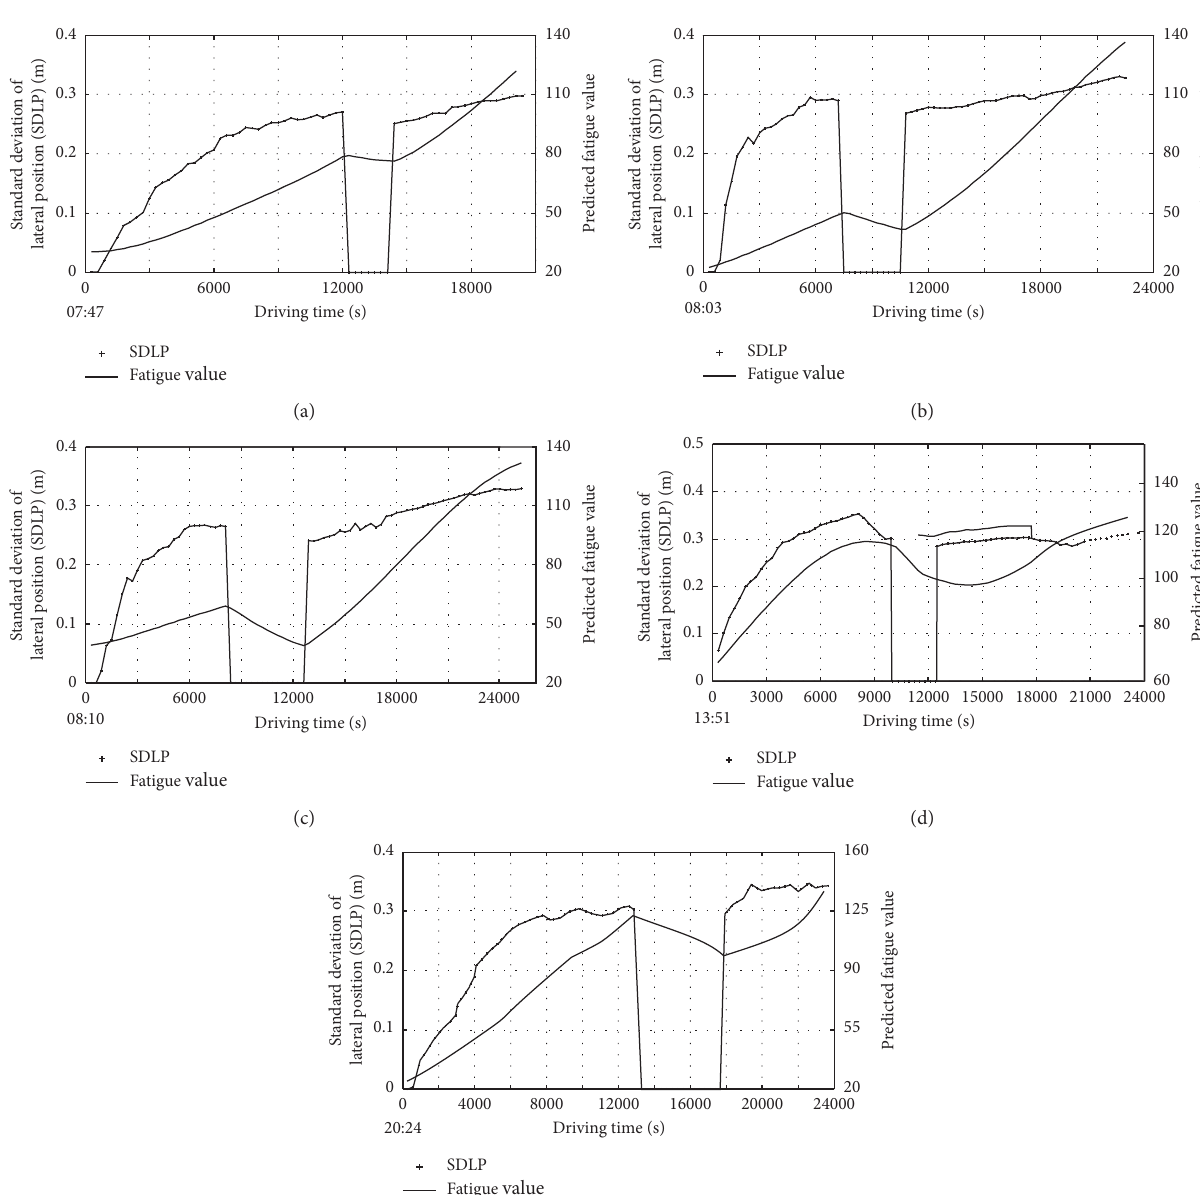
Figure 12: Comparison of the SDLP with the fatigue value of the three participants. (a) Subject with 7.4 hours of sleep. (b) Subject with 5.5 hours of sleep. (c) Subject with 3.8hours of sleep. (d) Subject with 7.7 hours of sleep. (e) Subject with 7.8hours of